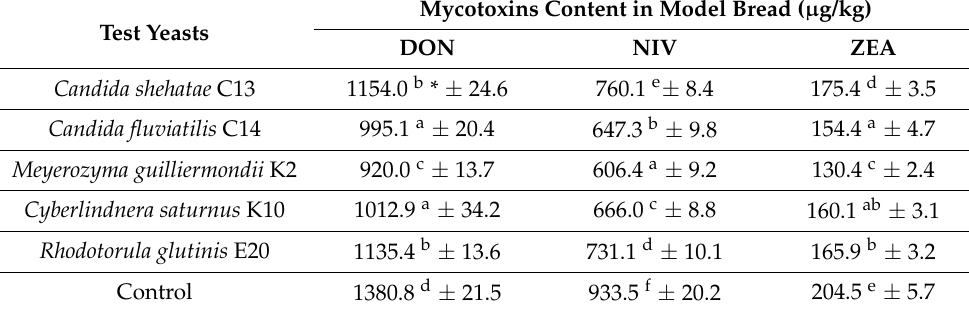
Table 4. The contents of mycotoxins in model bread obtained from wheat grain inoculated with F. culmorum, F. graminearum and F. poae and the test yeasts.